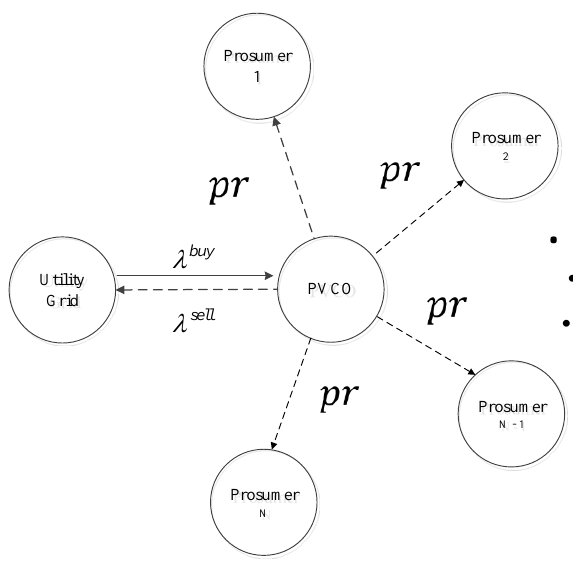
Figure 2. Relationship and prices of energy exchanges among prosumers, PVCO and the utility grid.